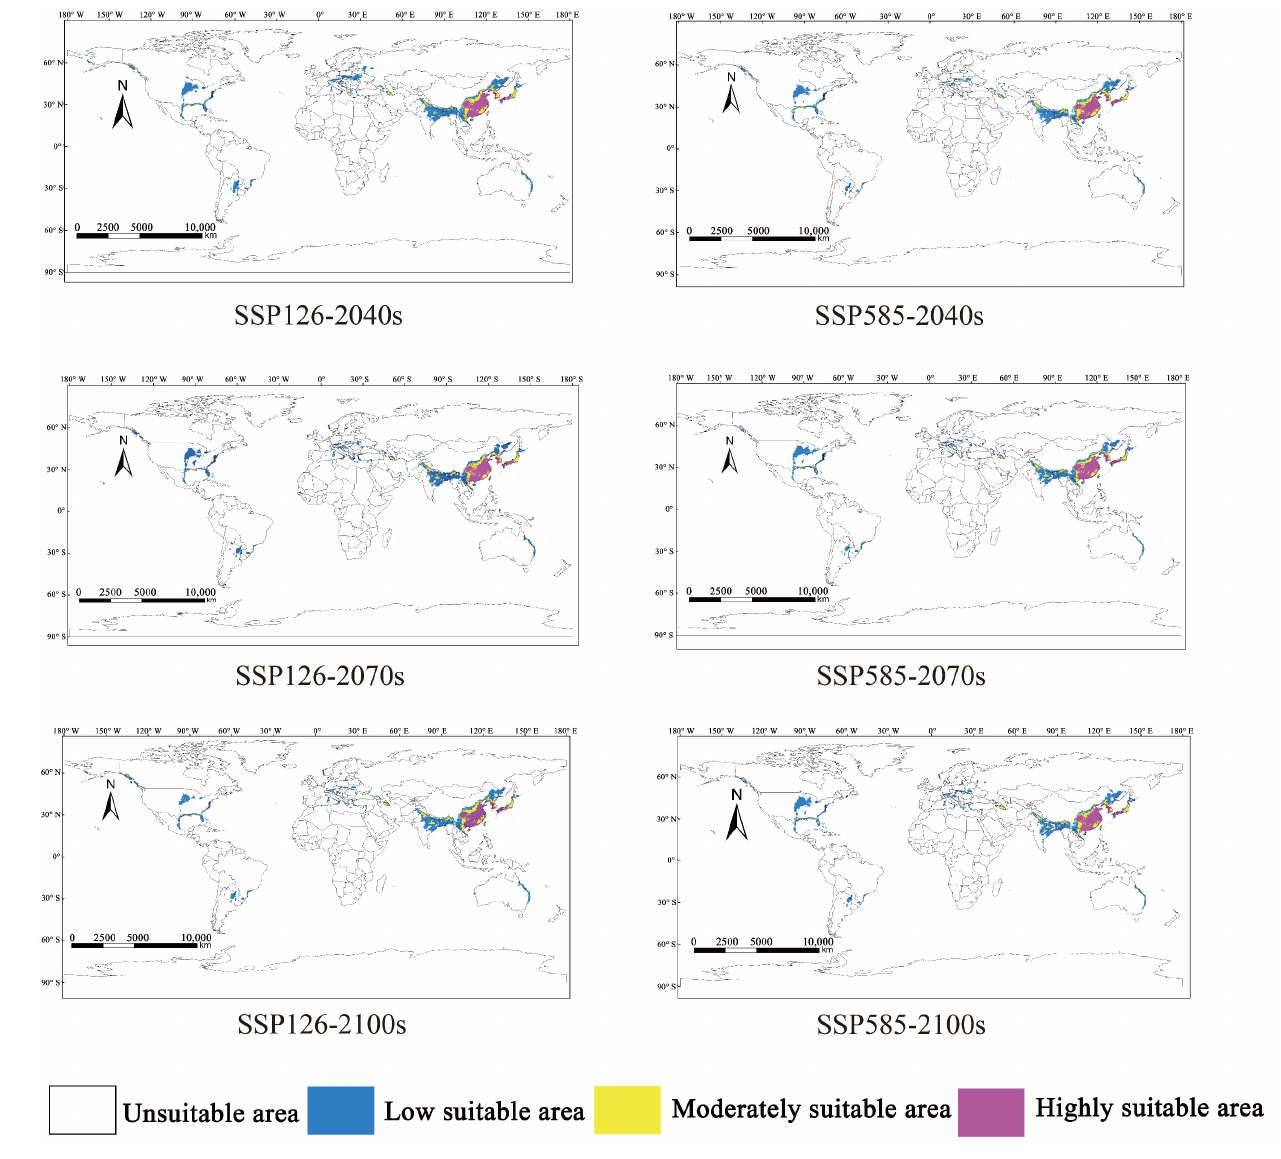
Figure 4. Predicted potential suitable distribution areas of M. alternatus at global scale under the future climate conditions of SSP126 and SSP585.